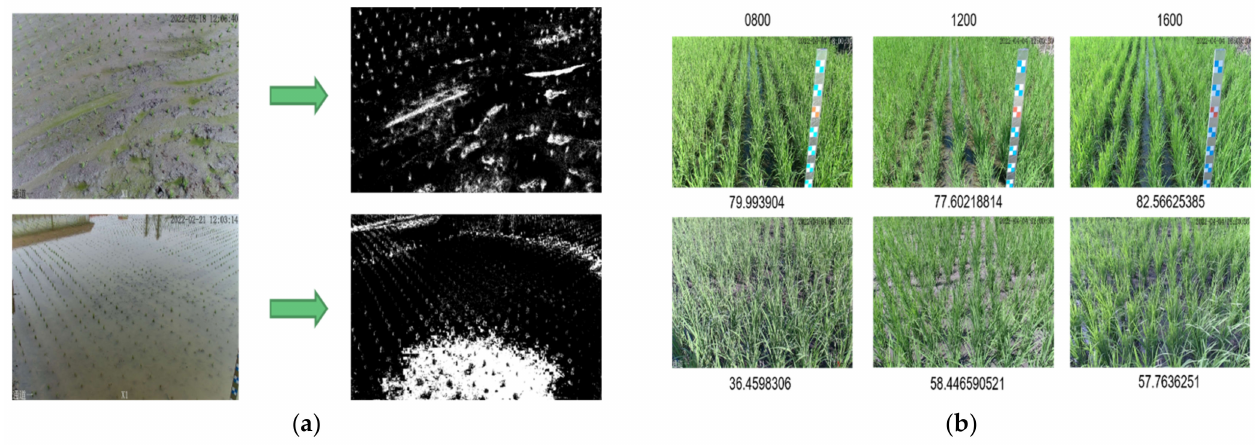
Figure 14. Effect of Algae and Light Intensity Throughout Day on the GC Rate. ( a ) Algae-infested and Flooded Fields. ( b ) Different Green Coverage Results Throughout the